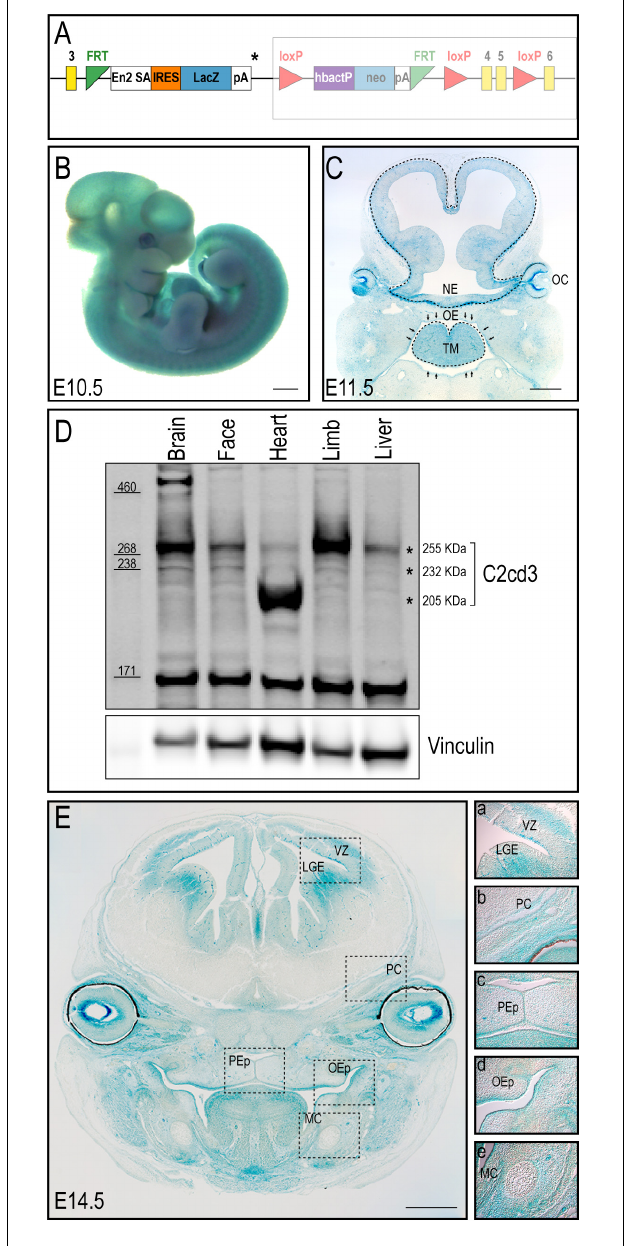
FIGURE 1 | C2cd3 expression in developing mouse embryos. (A) Schematic of C2cd3 LacZ targeted allele. LacZ expression cassette containing a stop codon (*) was inserted after exon (yellow box) 3. The remaining, unexpressed part of the construct designed for conditional knockout is indicated in the shaded box. (B) Whole mount X-gal staining indicates ubiquitous C2cd3 expression in E10.5 embryos. (C) Frontal section of an E11.5 embryo showing robust C2cd3 expression in neural epithelium (NE, dotted line), otic cup (OC), oral epithelium (OE, arrows) and tongue mesenchyme (TM, dotted line). (D) Western blot of C2cd3 expression in different tissues of E11.5 wild type embryos, showing three C2cd3 isoforms (asterisks). (E) Frontal section of E14.5 embryo, revealing robust C2cd3 expression in the lateral ganglionic eminence (LGE) and ventricle zone (VZ) of developing neocortex, perichondrium (PC) of developing cranial bones, palatal epithelium (PEp), oral epithelium (OEp) and mesenchyme surrounding Meckel’s cartilage (MC). All scale bars: 0.5